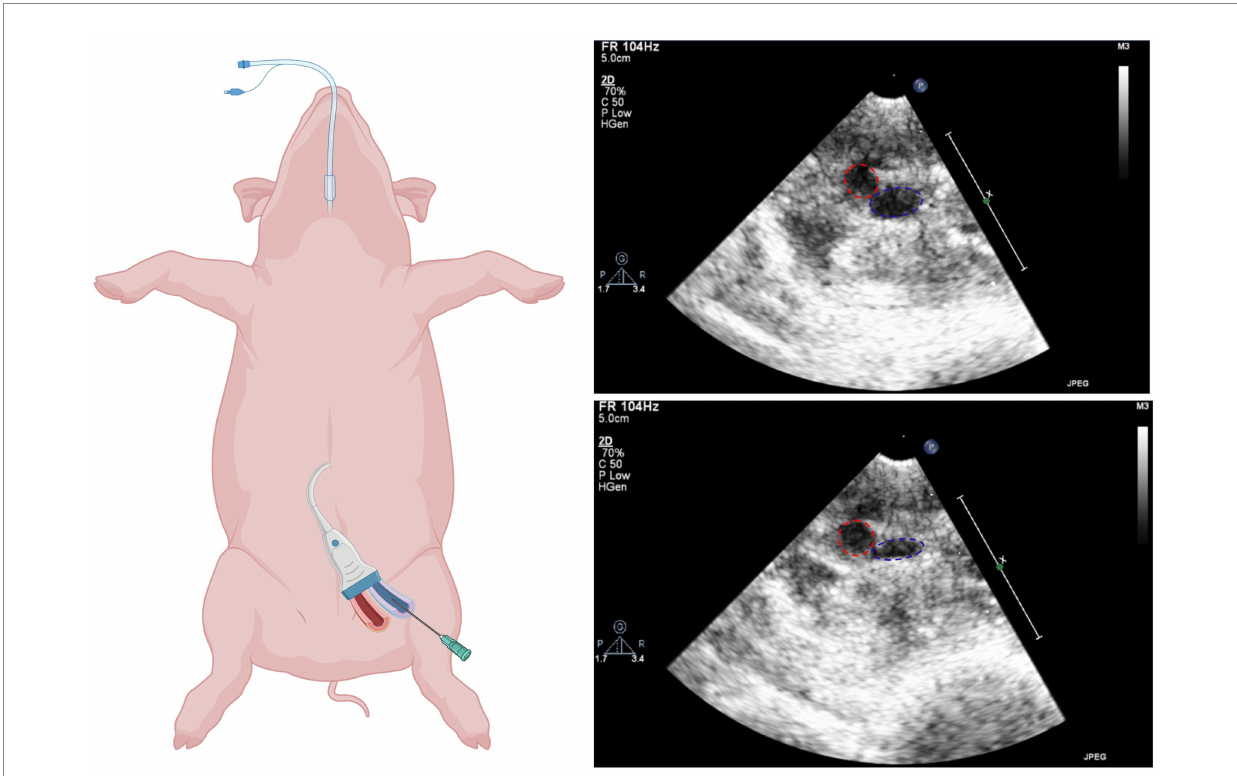
FIGURE 1 Ultrasound guided femoral access. Left: Schematic illustration of vascular access (biorender.com). Right: Ultrasound images of femoral artery (red) and femoral vein (blue) before (top) and after (bottom) compression.